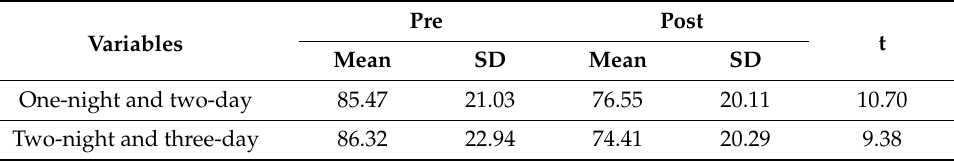
Table 8. Comparison of the effects between the one-night and two-day and two-night and three-day programs for